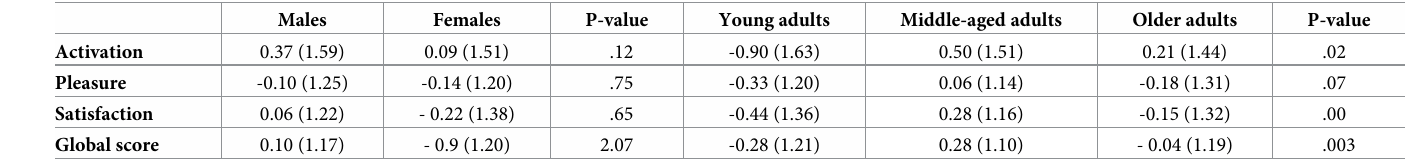
Table 5. Mean and standard deviation of the three dimensions and of the global score of STS before COVID-19. Males Females P-value Young adults Middle-aged adults Older adults P-value